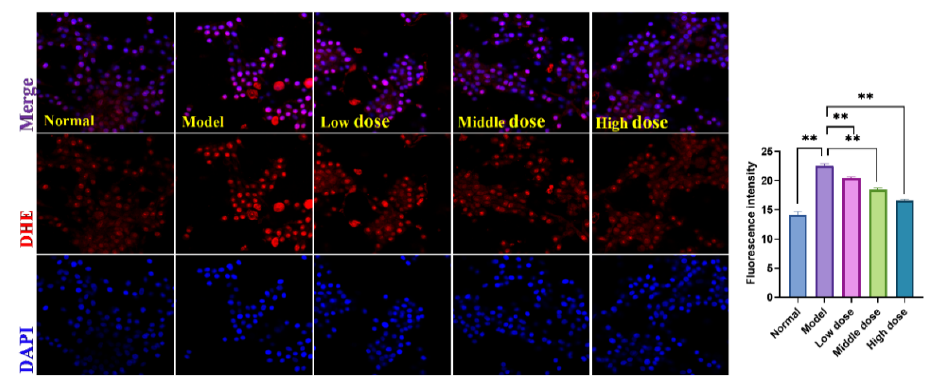
Figure 11. Effects of SMP on ROS levels in H 2 O 2 -induced PC12 cells ( × 40). PC12 cells were treated with SMP (4%, 8%, and 16%) for 24 h and subsequently subjected to H 2 O 2 (100 µ M) for 24 h. The intracellular ROS levels in the PC12 cells were observed by laser confocal microscopy under a 40× microscope. SMP: Salvia miltiorrhiza-containing plasma; ROS: reactive oxygen species. The values were expressed as mean ± SD ( n = 3), ** p < 0.01 vs. model group.